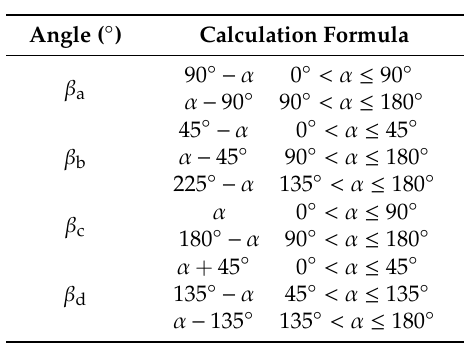
Figure 11. The extraction process of grinding marks. Table 2. Formula for calculating grinding marks